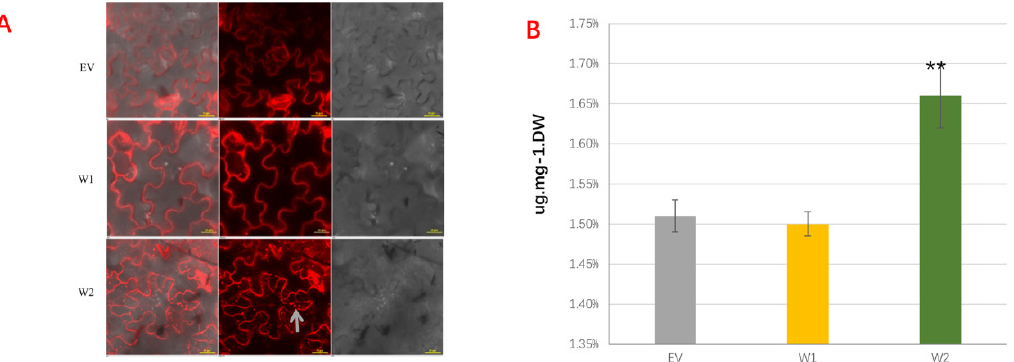
Figure 4. Functional analyses of TaWRI1Ls in N. benthamiana leaves. ( A ) The oil bodies under the laser confocal microscope. Arrow indicate oil bodys. ( B ) The triglyceride contents in tobacco leaves. EV: empty vector; W1: pYBA1302-W1 ( TaWRI1L1-5B ); W2: pYBA1302-W2 ( TaWRI1L2-5A ). Data are represented as means ± SD from independent biological replicates, and p -values are indicated by Student’s t -test (** p < 0.01). Bars = 25 µm.